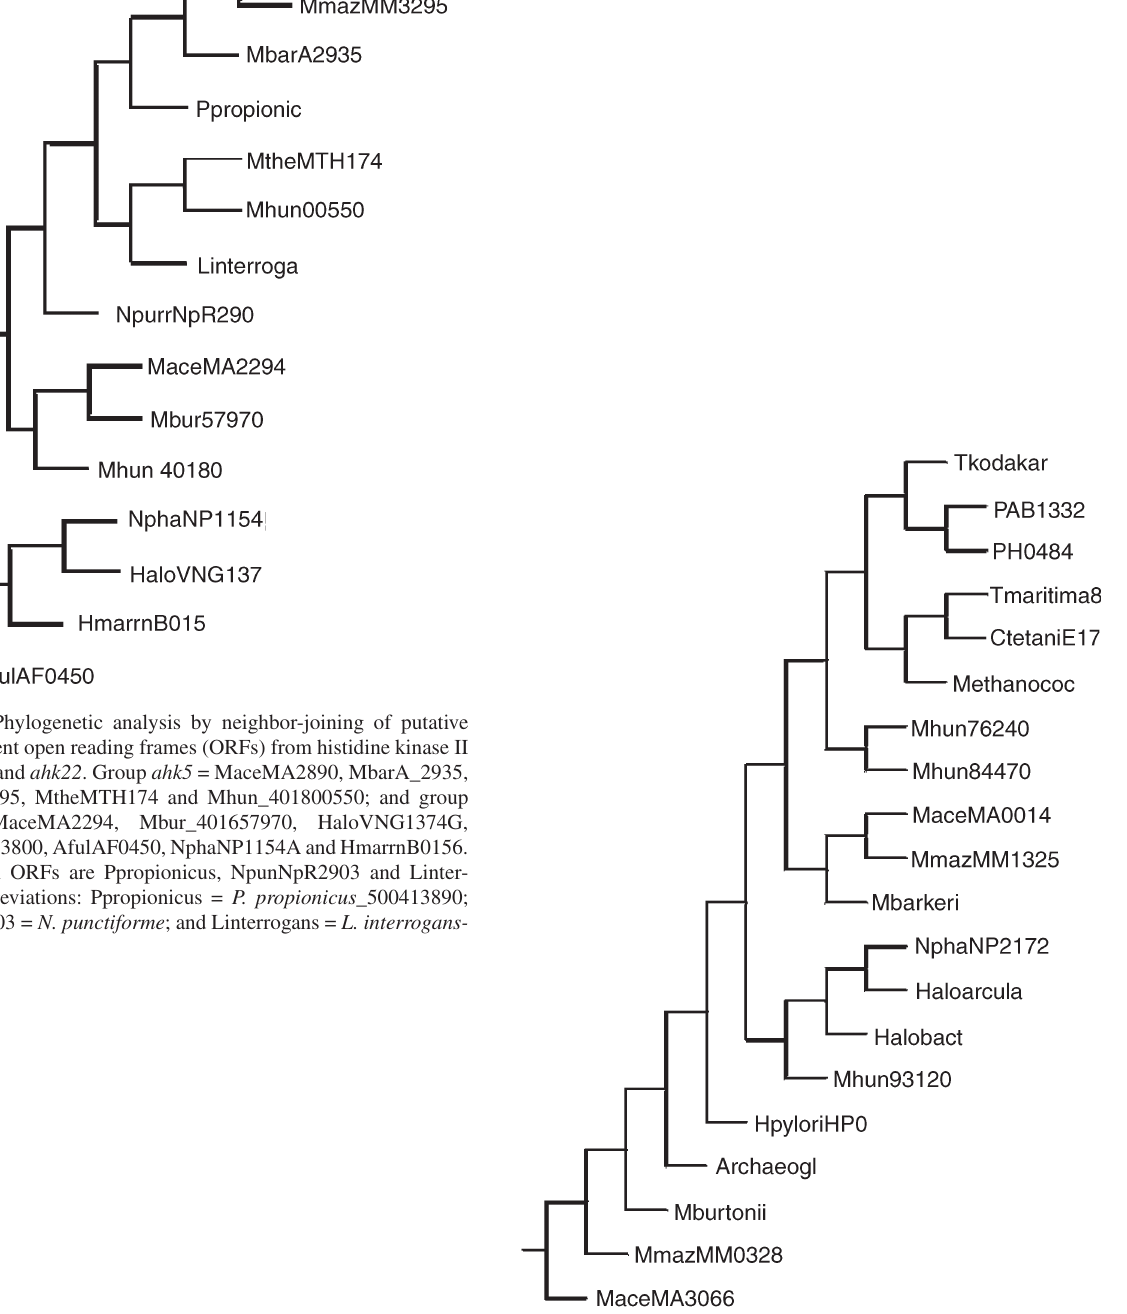
Figure A2. Phylogenetic analysis by neighbor-joining of putative two-component open reading frames (ORFs) from histidinekinase VI groups ahk40–43 . Group ahk40 = MaceMA3066, MmazMM0328, AfulAF1040 and Mbur_ 401647520; group ahk41 = MaceMA0014,